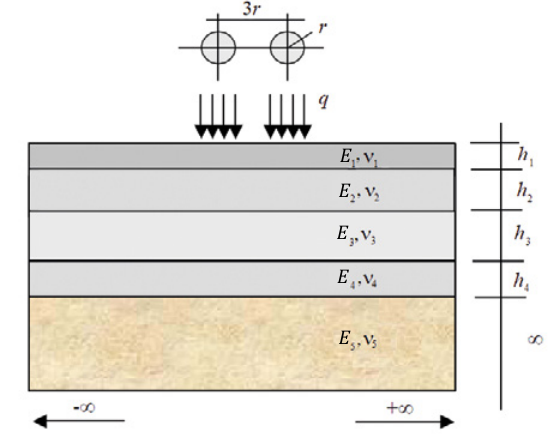
Figure 1. Configuration of tyres for the standard axle over a multi-layered pavement characterised by Elastic modulus ( E i ), Poisson ratio